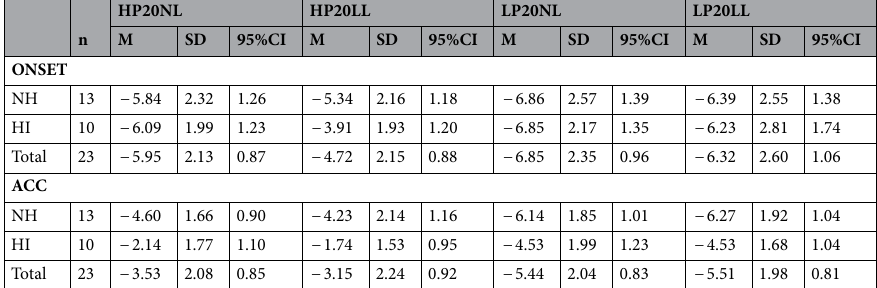
Table 2. Mean z-scores of cortical responses to onset (top panel) and acoustic change complex (ACC) (bottom panel) for normal-hearing (NH) and hearing-impaired (HI) subjects. The four stimulus conditions were: